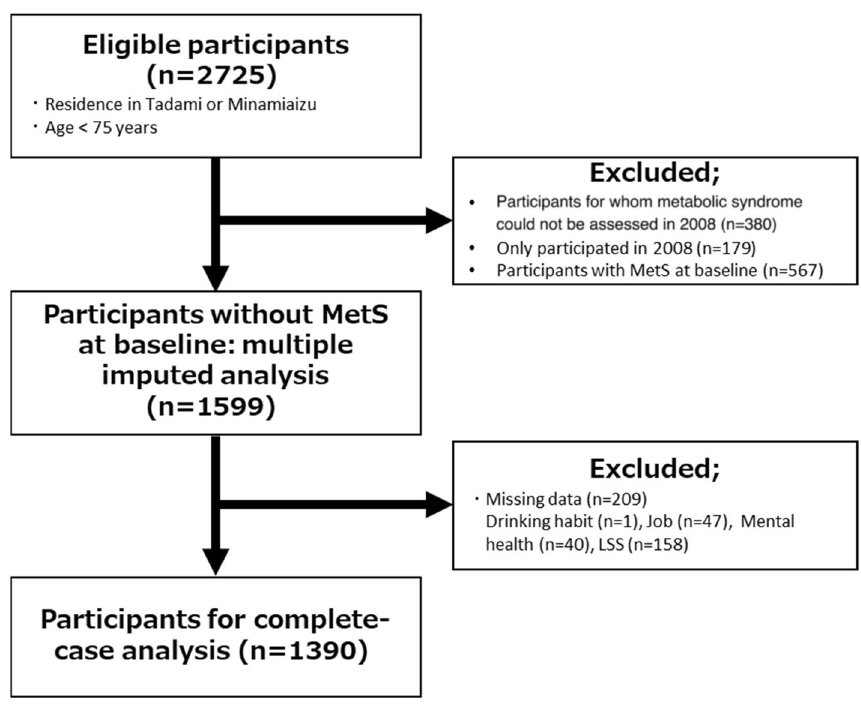
Figure 1. Flowchart for the study. A total of 1390 subjects were included in the complete-case analysis, and 1599 in the multiple imputation sensitivity analysis. MetS metabolic syndrome, LSS lumbar spinal